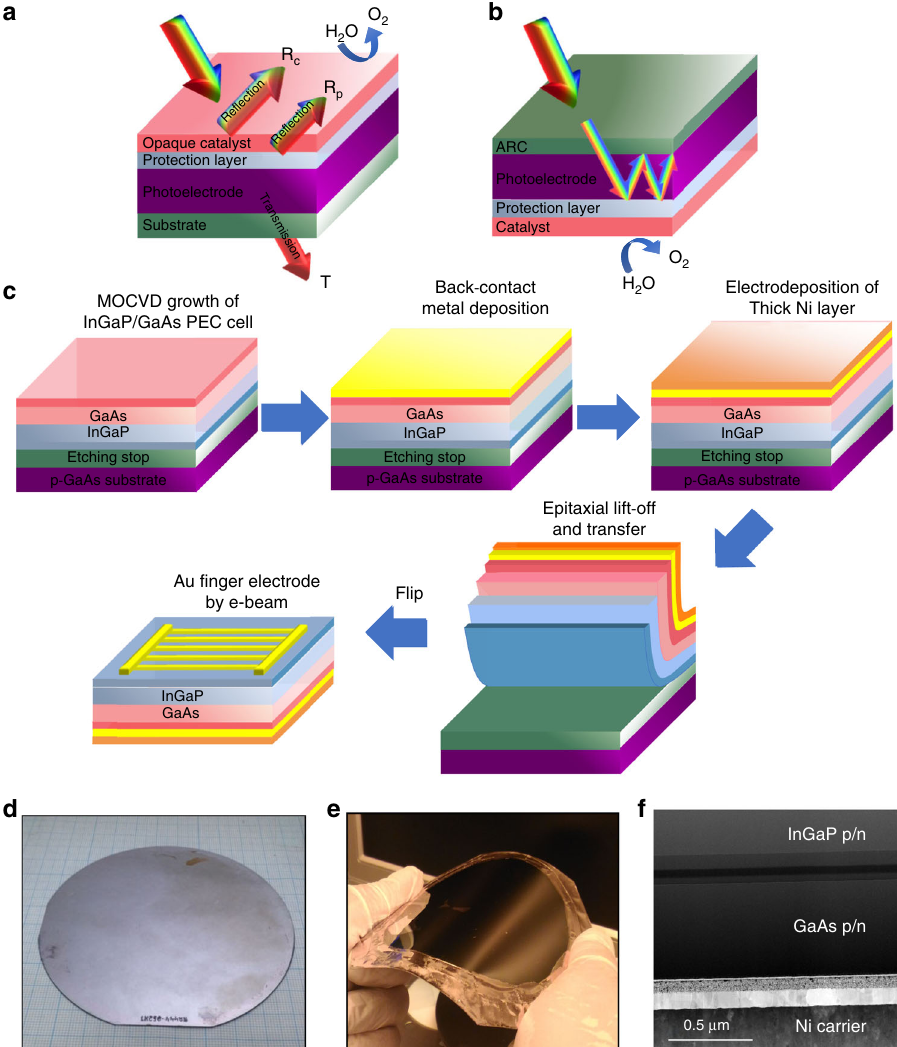
Fig. 1 Decoupling optical absorption and electrocatalysis. a The typical monofacial PEC device design, in which all functionalities, such as the surface protection layer and electrocatalyst, are integrated on top of the light harvesting side, whereas the bottom side is only used for the electrical connection. The opaque catalytic re fl ection (Rc) and protection layer re fl ection (Rp) signi fi cantly block light absorption in current monofacial PEC devices. b Our novel, light-decoupled device, in which the light harvesting component is decoupled from the surface protection and electrocatalysis functions. c Schematic illustration of the steps involved in the ELO and transfer processes to fabricate the integrated InGaP/GaAs tandem photoanode on a fl exible substrate for PEC water splitting. d , e A wafer-scale inversely grown InGaP/GaAs on single crystalline GaAs substrate before ( d ) and after ( e ) ELO and transfer onto a fl exible Ni carrier wafer. f Cross-sectional TEM image of the transferred tandem photoanode on the Ni